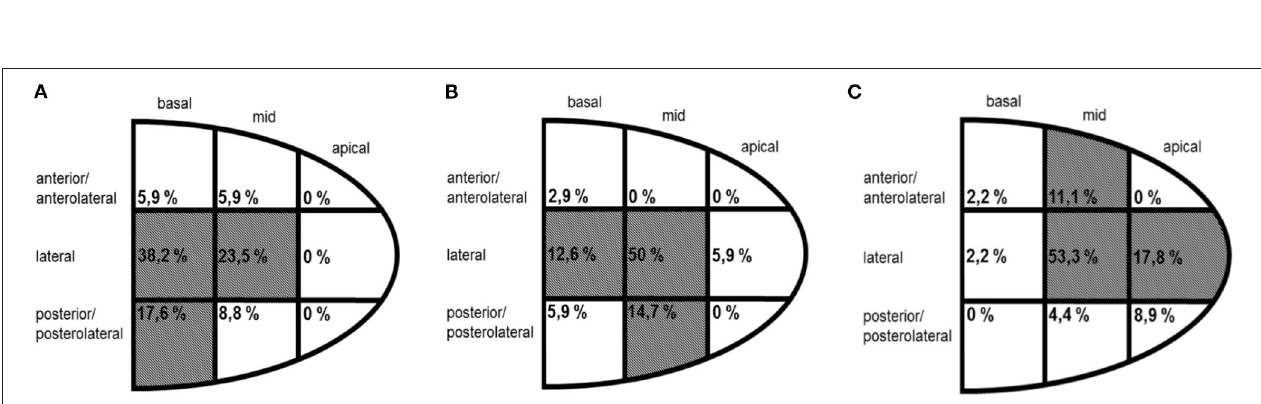
FIGURE 4 | Location of the helix (A) and tip (B) of bipolar active fixation electrode and the tip of quadripolar passive fixation electrode (C) according to fluoroscopy shown in percentages (%) by region of the final